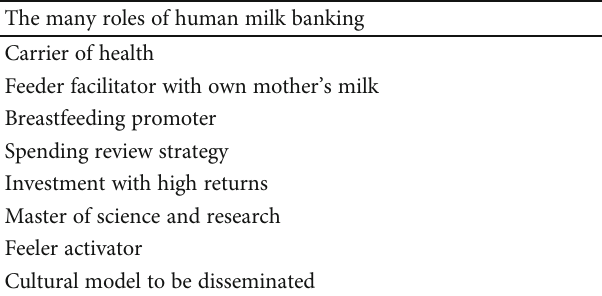
The many roles of human milk